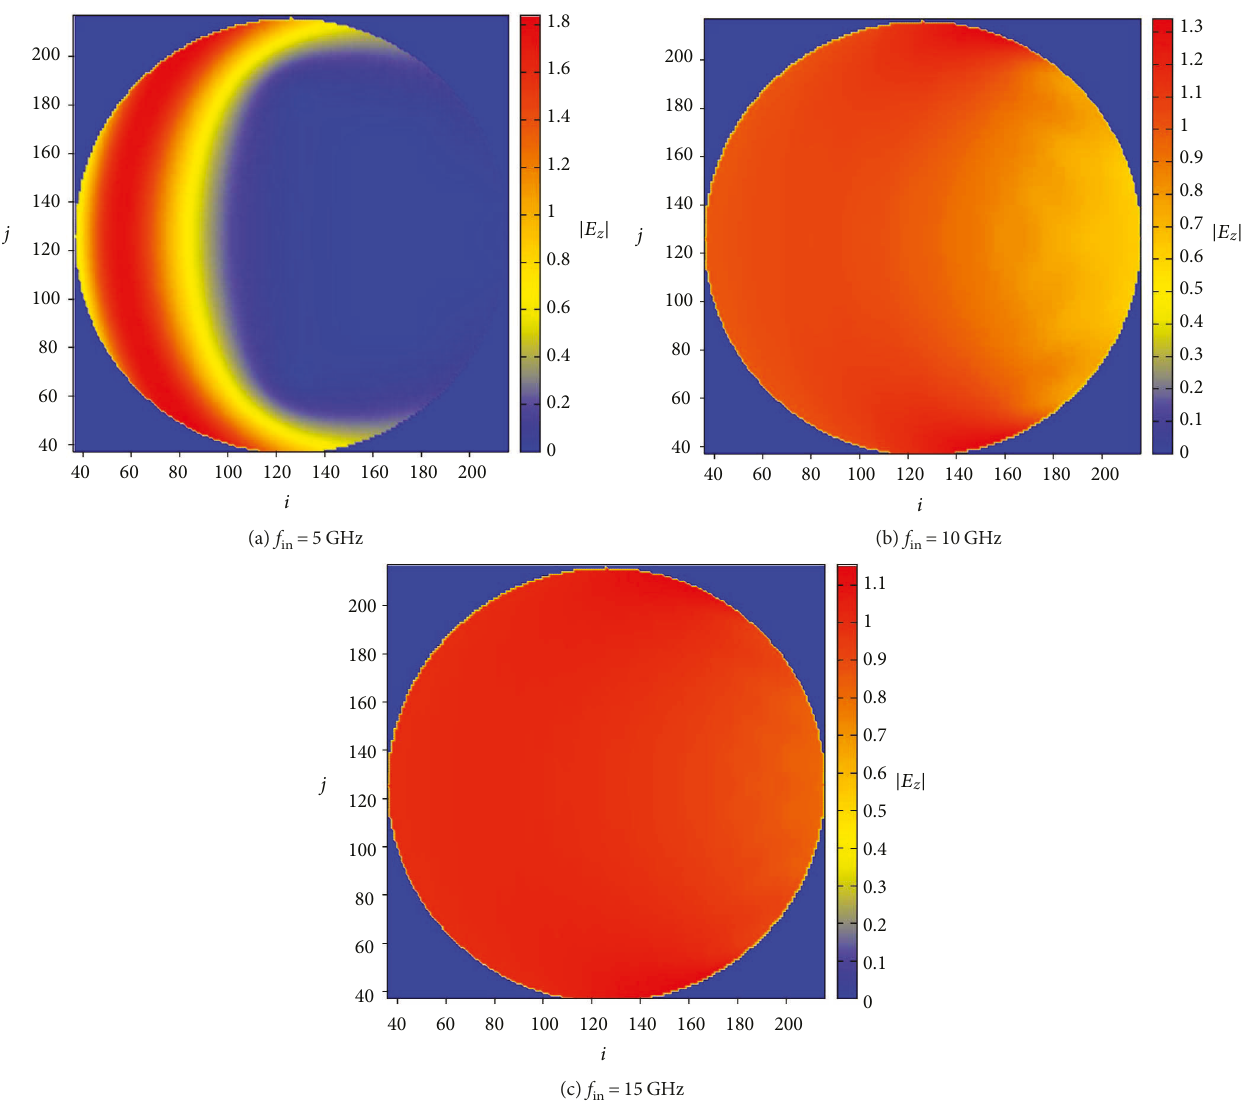
Figure 14: Magnitude of the electric fi eld, in volts/meter, within the inhomogeneous plasma cylinder obtained by the FDTD simulation for di ff erent incident frequencies f . Central electron density is set to n =5 × 10 17 m − 3 , and electron collision frequency is set to ν =500 × 10 6 in 0